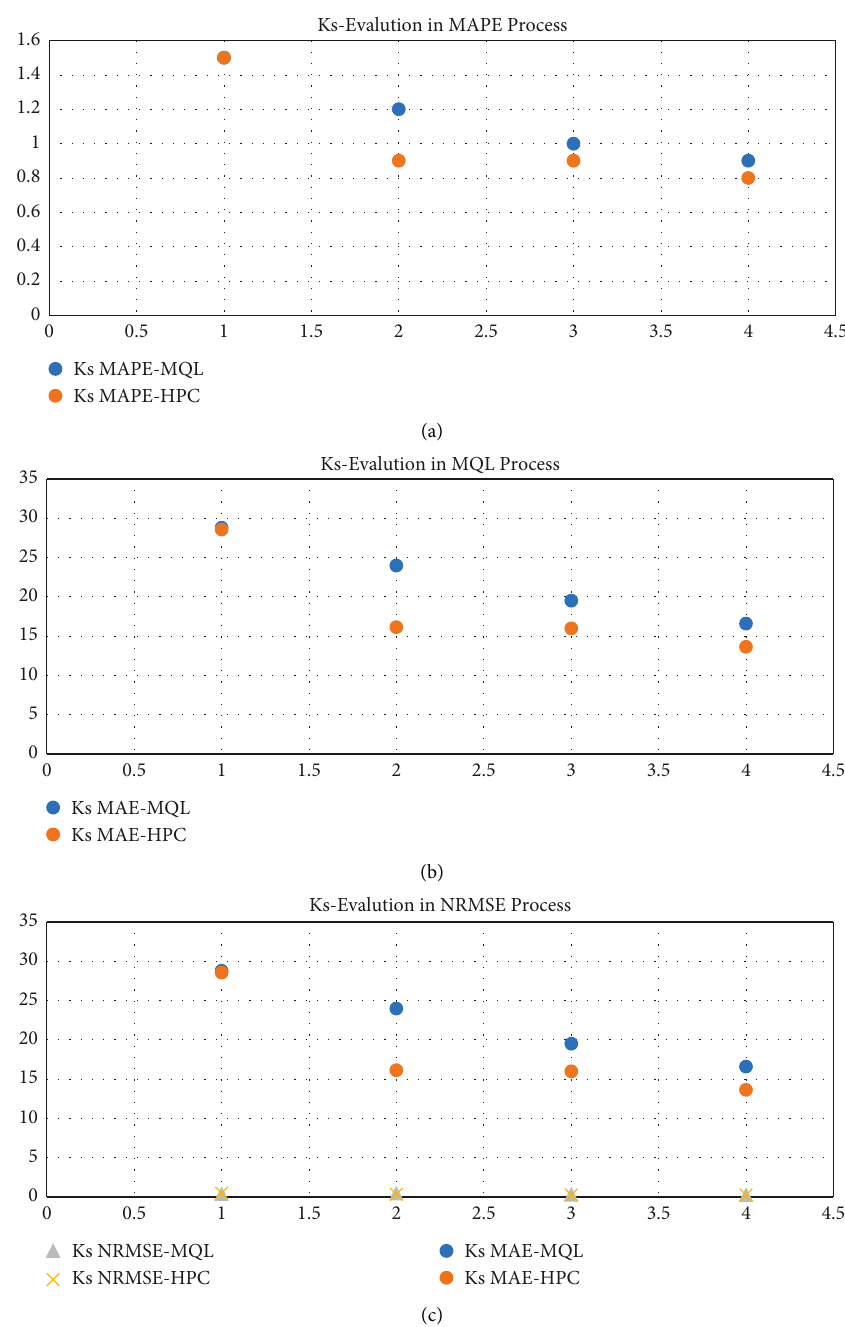
Figure 6: (a–c) Machine learning performance for reducing cutting pressure. (a) Ks-evaluation in MAPE models. (b) Ks-evaluation in MQL process. (c) Ks-evaluation in NRMSE